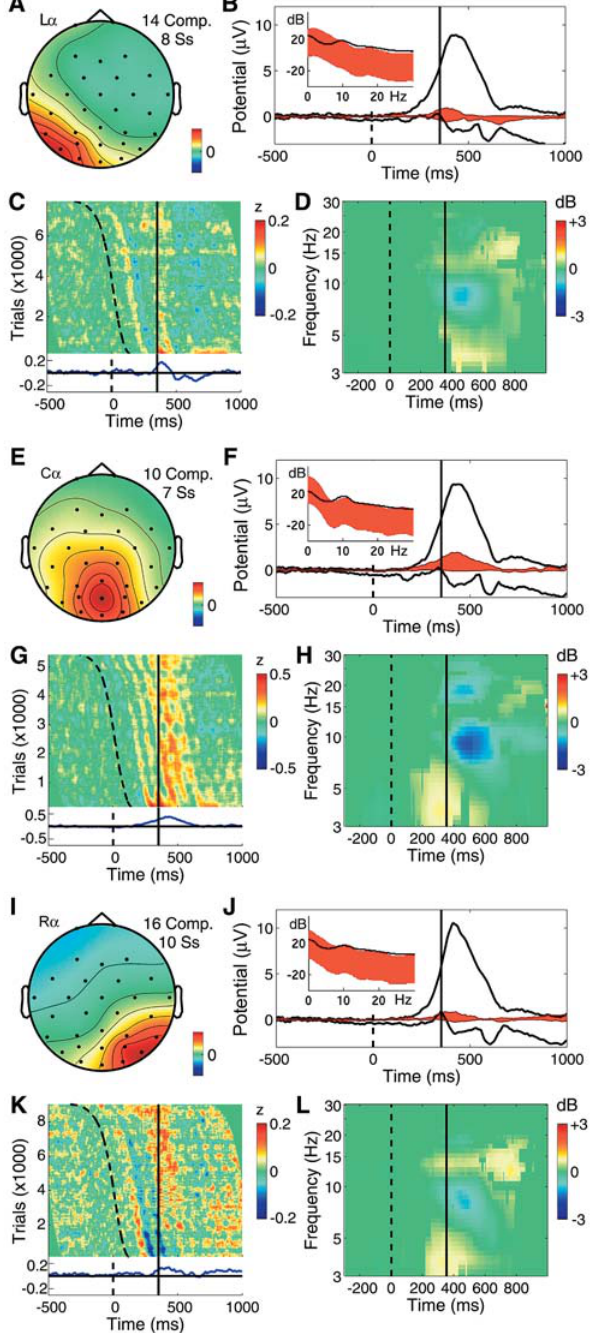
Figure 9. Three Posterior Alpha-Rhythm Component Clusters Panels as in Figure 6. (A–D) Left posterior alpha (L a ) component cluster. (E–H) Central posterior alpha (C a ) component cluster with charac- teristic trapezoidal scalp projection, consistent with a bilateral, pericalcarine equivalent dipole source model, and demonstrating prolonged phase resetting following stimulus onset (curving dashed trace). (I–L) Right posterior alpha (R a ) component cluster. Note (C) the relative absence of the alpha-ringing pattern in the L a cluster activity and the (D, H, and L) relatively weak postresponse alpha blocking in these clusters. DOI: